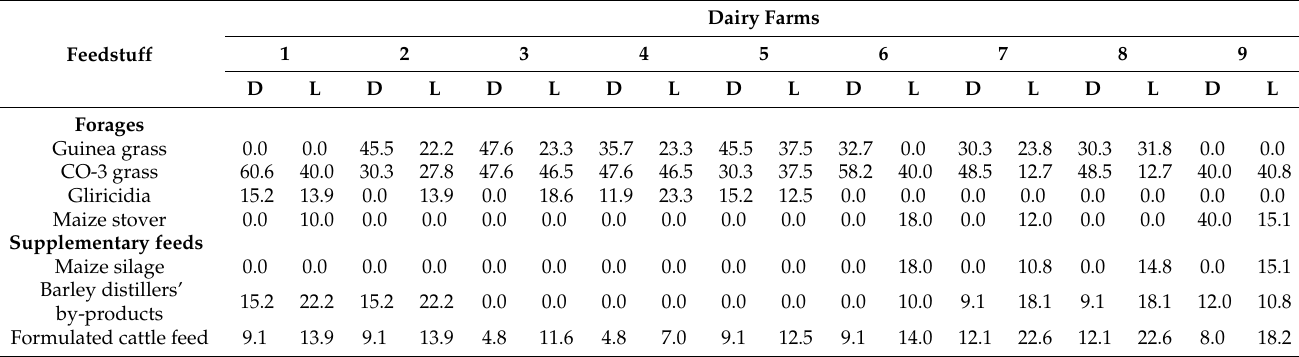
Table 4. Components (feedstuff) of the manually mixed rations given to dry and lactating dairy cows at each of the nine dairy farms selected for this study.